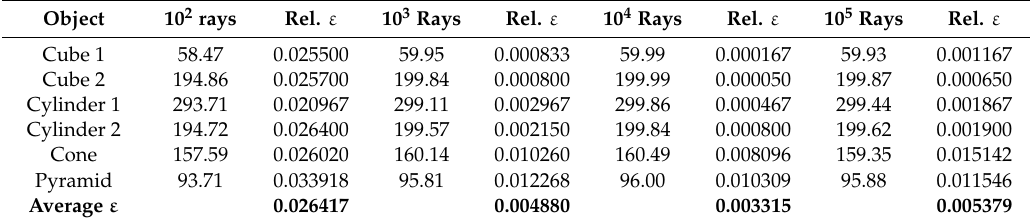
Table 2. Perimeter estimates in cm for di ff erent numbers of rays and relative error (Rel. ε ). Object